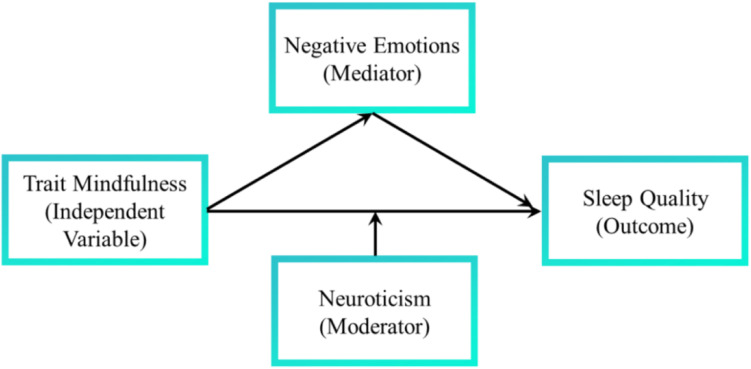
The proposed model.